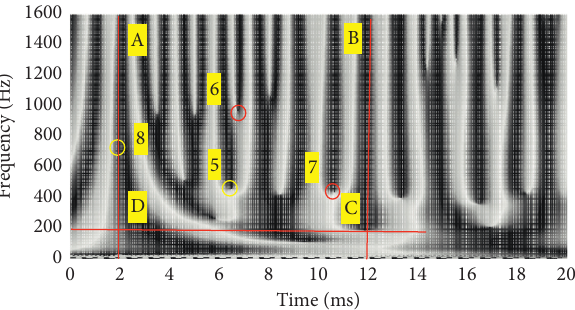
Figure 13: Grayscale images of phase angles.